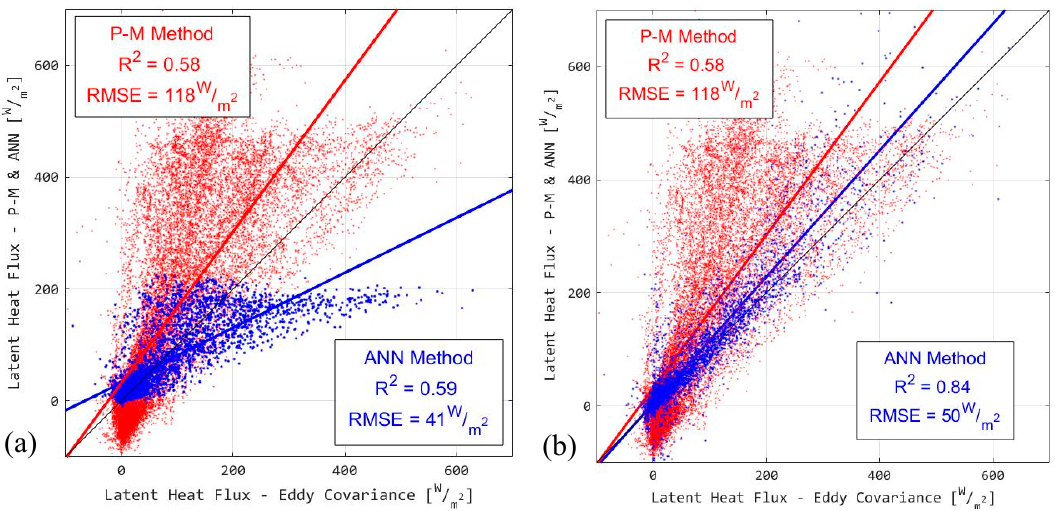
Figure 4. Results at site 1 from ( a ) 3-day training and ( b ) 14 day training period. The RMSE indicates the departure of the dependent values (P-M and ANN) from the eddy covariance control.